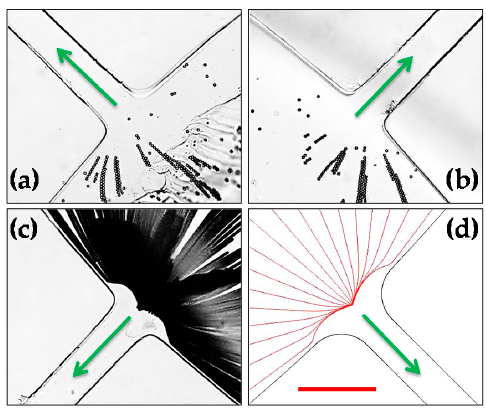
Figure 3. Electrokinetic trapping and concentration of 5- μ m-diameter polystyrene particles inside the central inlet reservoir of the stacked microfluidic device under the application of a 50-V DC-biased 500-V AC voltage: ( a ) snapshot image in Layer A (see Figure 1); ( b ) snapshot image in Layer B; ( c ) superimposed image at a different reservoir-microchannel junction of Layer A; and ( d ) numerically predicted trajectories at any reservoir-microchannel junction. The arrows indicate the fluid and particles moving directions from the central inlet reservoir into the parallel microchannels. The scale bar represents 100 μ m and applies to all images.